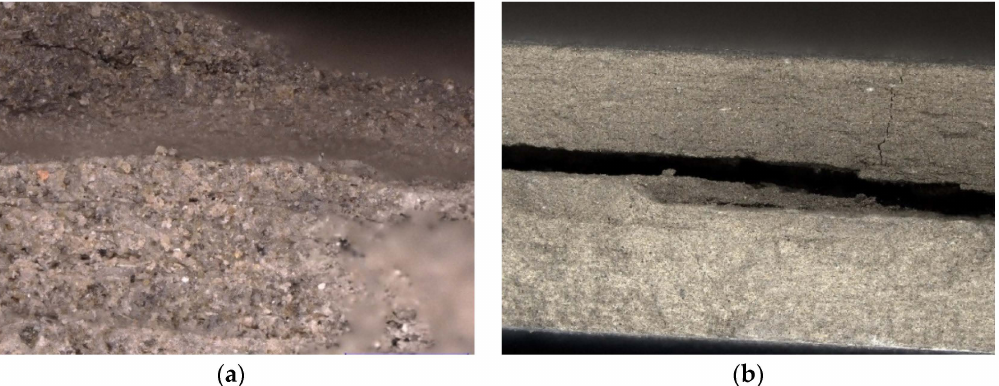
Figure 12. Example view of the D5 sample under a digital microscope: ( a ) magnification × 150, ( b ) magnification ×